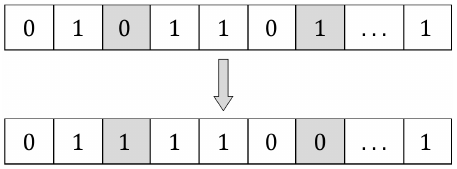
Figure 4. Exchange: a term “0” and a term “1” are randomly selected and exchanged.